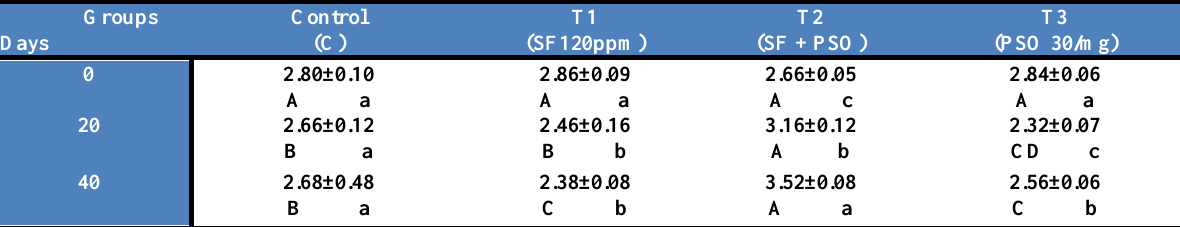
Table, 3: Effect of pomegranate seed oil (PSO) on serum globulin concentration (g/dl) in female rats treated with sodium fluoride